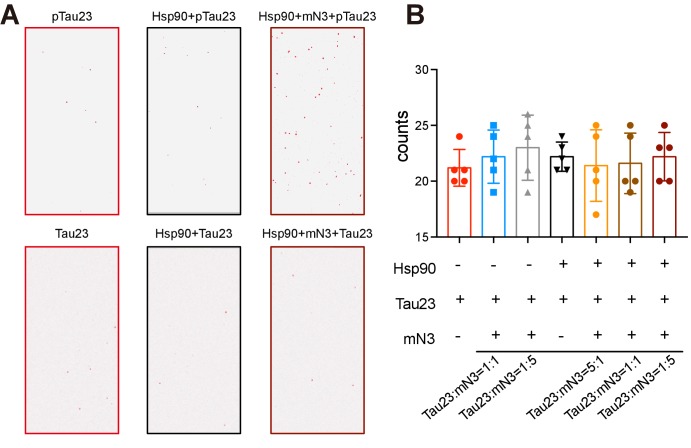
mN3 mediates the binding of pTau23, but not Tau23, to Hsp90.(A) TIRF microscopic images show the enhancement of mN3 to the binding of Hsp90 with pTau23 but not Tau23. (B) The average number of fluorescent counts per imaging area detected by SMPull. The concentrations of mN3 from left to right are 0, 4, 20, 0, 0.8, 4, and 20 nM. Error bars denote standard deviations (s.d.) (n = 10).